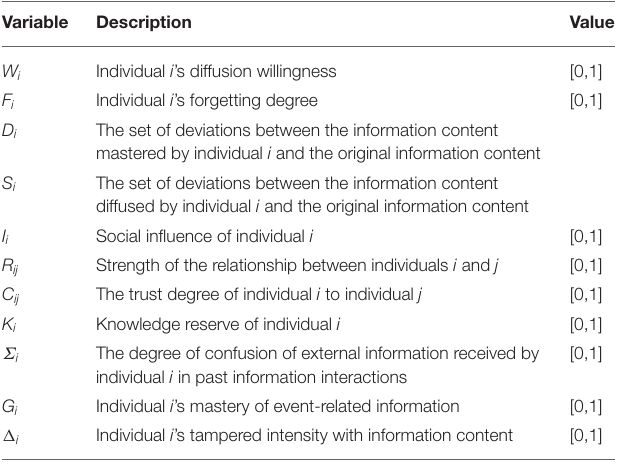
TABLE 2 | Involved variables in the